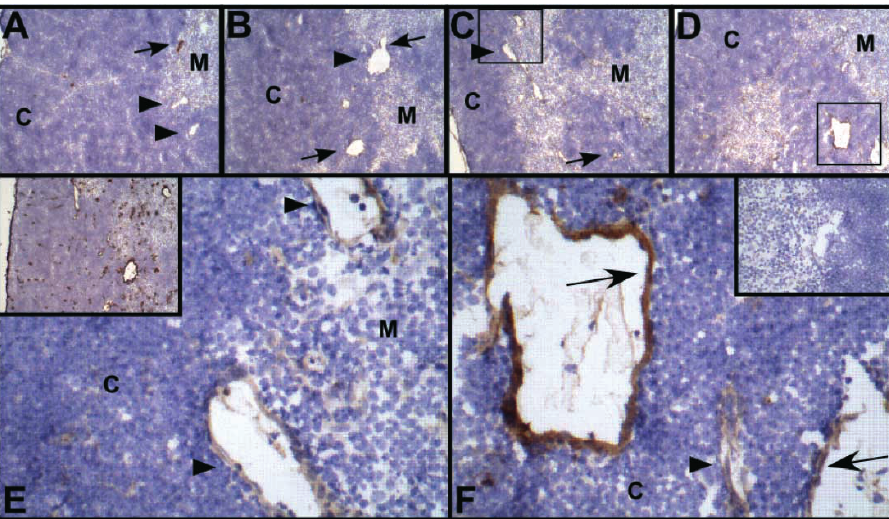
FIGURE 1 MECA79 is expressed on specific vascular structures in the mouse thymus. MECA79 was examined by immunohistochemistry on thymic sections of animals at 4 weeks (A), 5 weeks (B), 7 weeks (C and E) and 9 weeks (D and F) of age; these intervals encompass one complete cycle of progenitor recruitment (see text for further details). MECA79 expression was found on most venules near the sites of progenitor entry, and was most abundant at peak periods of progenitor recruitment (i.e. 5 and 9 weeks), and lower during refractory periods (4 and 7 weeks). Regions outlined by rectangles in panels C and D are enlarged in panels E and F, respectively. The inset on panel E shows thymic expression of CD34, one of the sialomucins that can be modified by MECA79; the inset on panel F is an isotype-matched antibody control. Original magnifications: A through D, 100 £ ; E and F, 400 £ . M ¼ medulla; C ¼